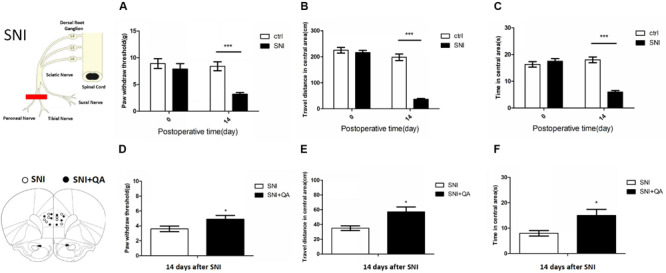
The SNI model of neuropathic pain induces mechanical allodynia and enhances anxiety-like behaviors. (A) Fifty percent of mechanical thresholds of mechanical allodynia were determined using von Frey filaments before surgery (baseline) and 14 days after surgery. (n = 8 rats per group; ***P < 0.001, two-tailed t-test). (B,C) Anxiety-like behaviors assessed in an OF test (n = 8 rats per group; two-tailed t-test). ***P < 0.001. (D–F) Paw withdrawal threshold and open field of the SNI rats after bilateral lesion of the PL by quinolinic acid, respectively (n = 8 rats per group; *P < 0.05, two-tailed t-test). The data are presented as mean ± s.e.m.